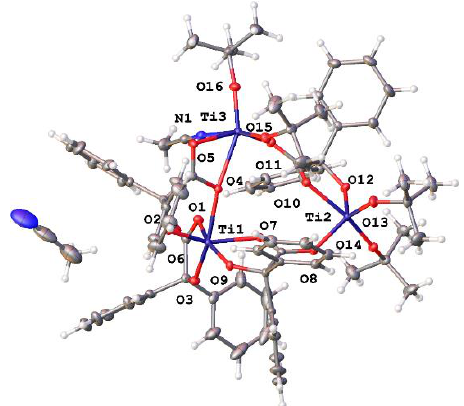
Figure 5. Asymmetric unit of 5 with atoms drawn as 50% probability ellipsoids. Selected bond lengths (Å) and bond angles ( o ): Ti(1)-O(10) 1.7393(10), Ti(1)-O(9) 1.7389(10), Ti(1)-O(6) 1.9703(10),